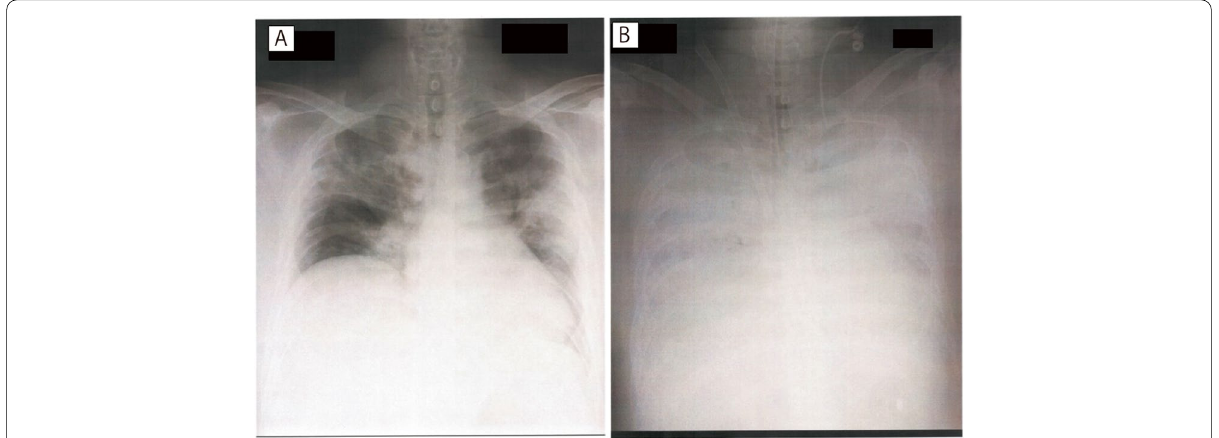
Fig. 1 Chest radiograph on admission to the ICU ( A ) and immediately following the initiation of extracorporeal membrane oxygenation (ECMO) ( B ). Diffuse shadows in the bilateral peripheral lung on admission and enhanced pulmonary vascular shadow with cardiac enlargement and decreased permeability after starting ECMO should be